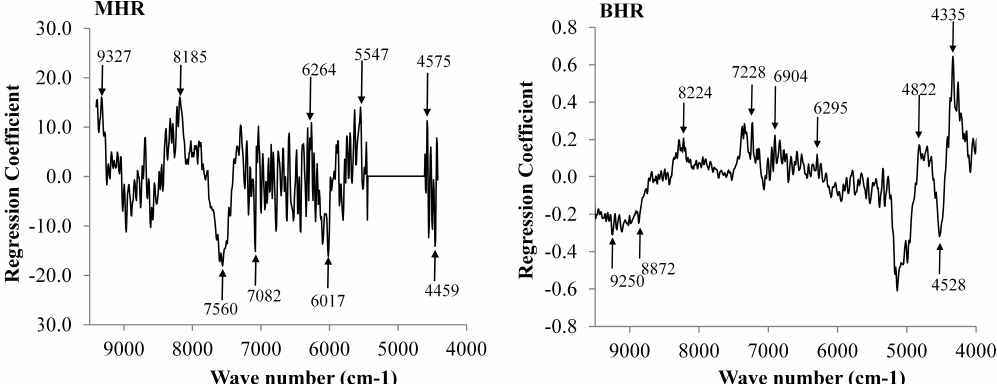
Fig. 6. Regression coe±cient plots of the validated models for DRW prediction in MHR (left) and BHR (right)